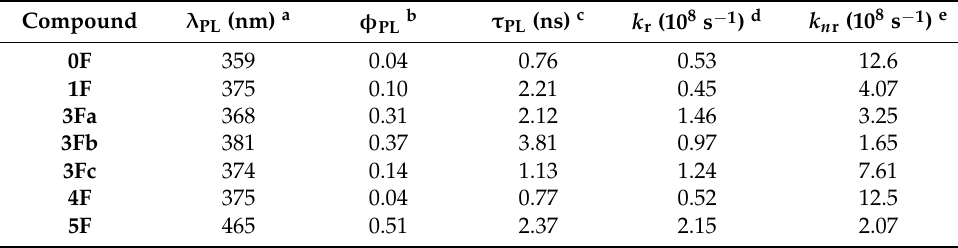
Table 2. Photophysical properties of tolanes 0F – 5F in the crystalline states.